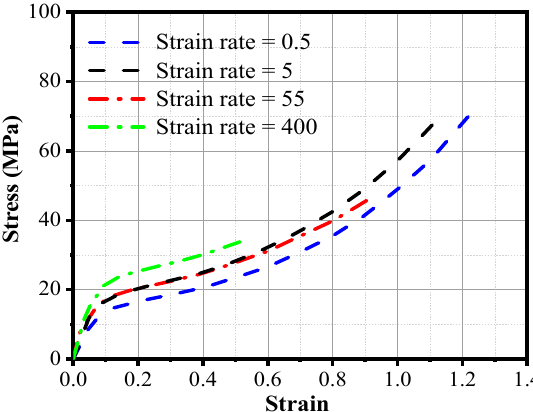
Figure 1. Stress-strain curves of SPUA at different strain rates.